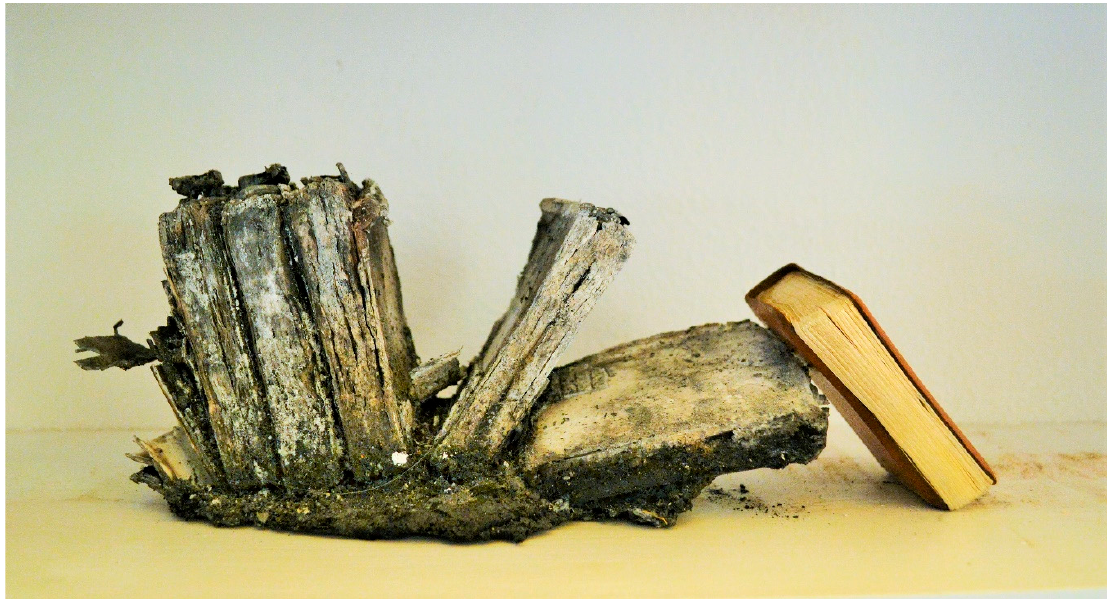
Figure 10. Une saison en Enfer. Photo by Agricubismo ® .